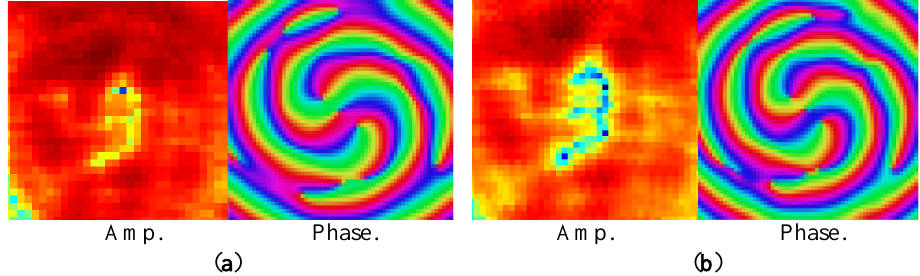
Figure 5. Amplitude and phase response for ( a ) X-polarization and ( b )